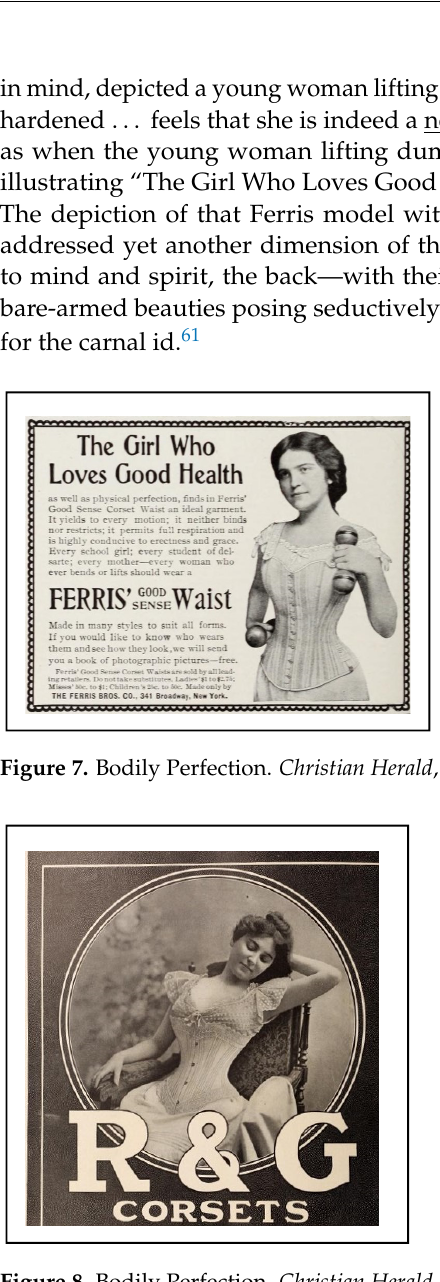
Figure 6. The Swoboda Method. Christian Herald , 6 January 1900, p. 918.